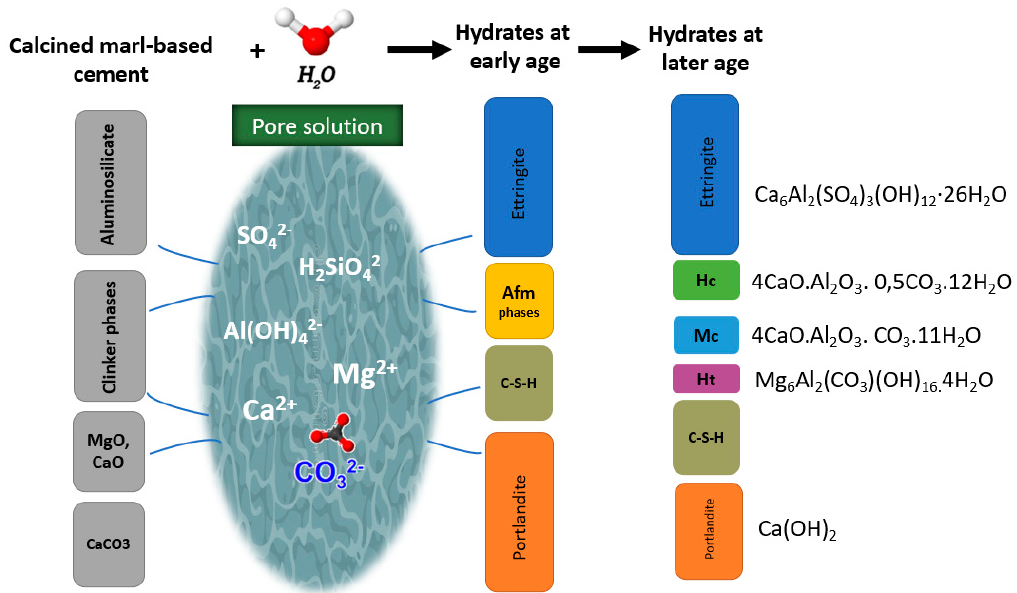
Figure 5. Schematic representation of the difference between the SCMs and the calcined marl hydration mechanism C-S-H: calcium silicate hydrates, Hc: hemi-carboaluminate hydrates, Mc: mono-carboaluminate hydrates, Ht: hydrotalcite.